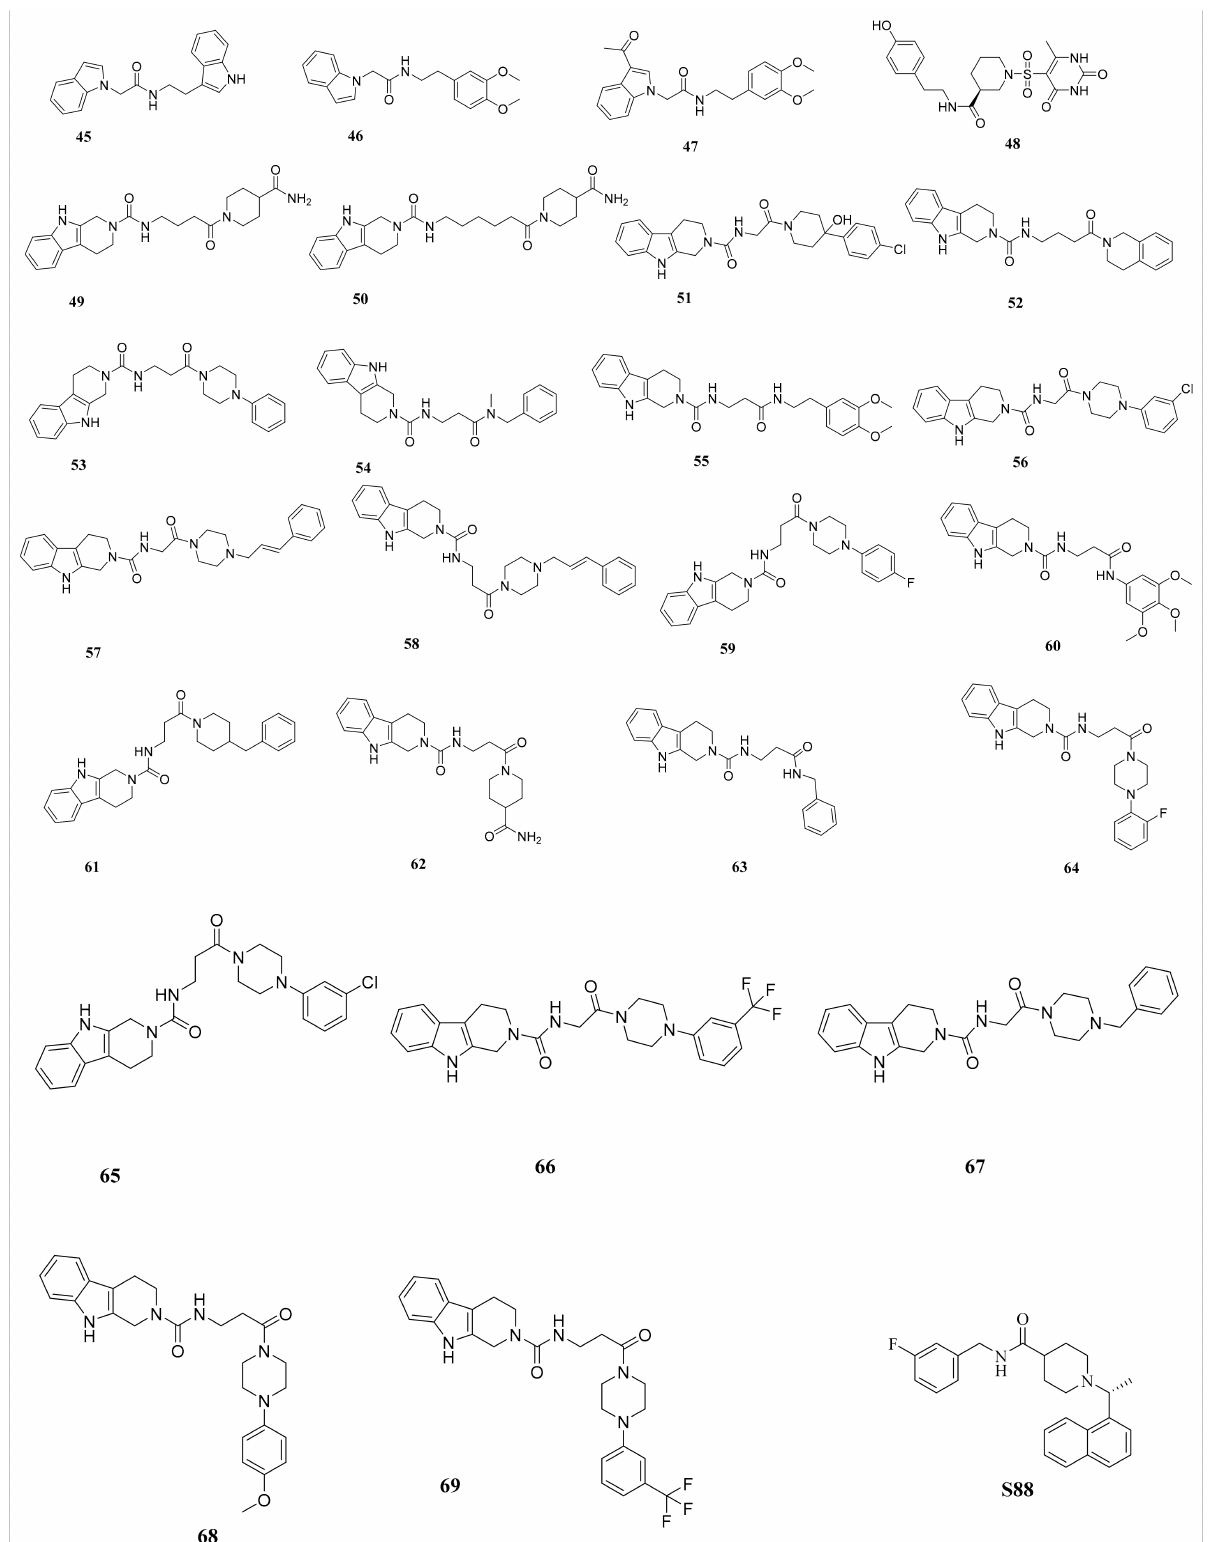
Figure 2. The chemical structures of the examined